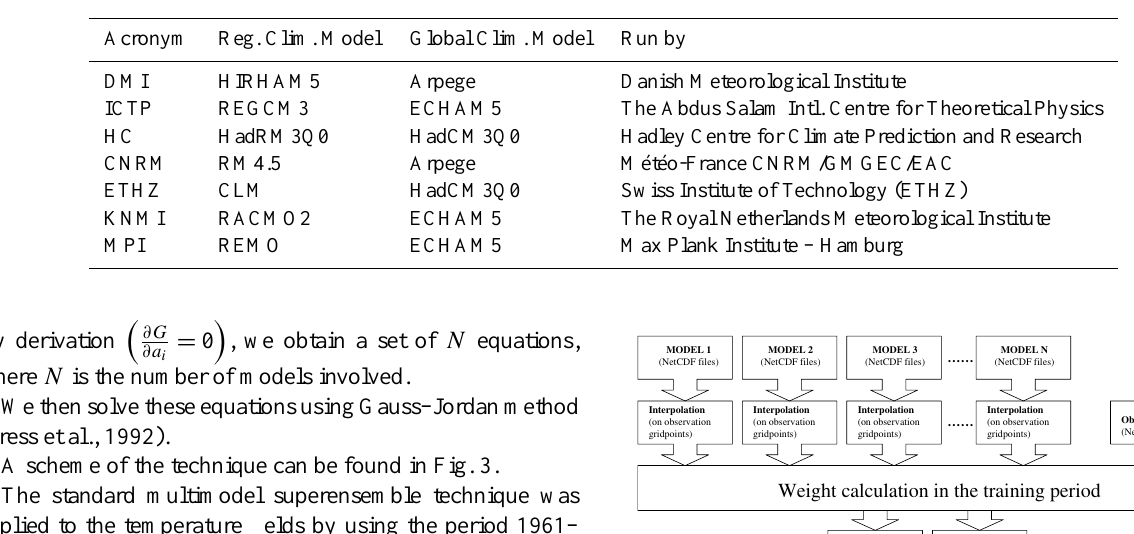
Table 1. The models used in the multimodel superensemble evaluation.